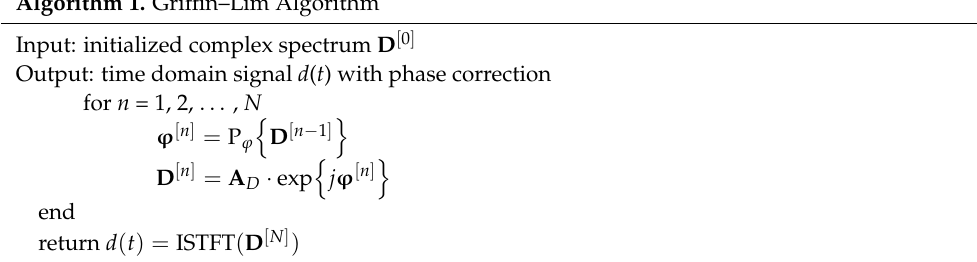
Algorithm 1. Griffin–Lim Algorithm